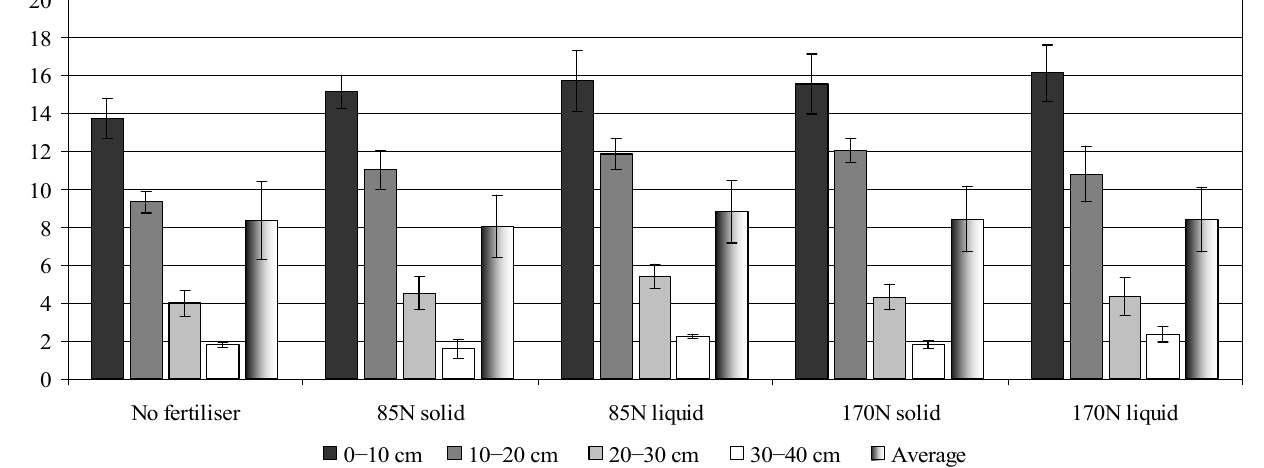
Figure 4. SOC content in grassland in Fluvisol, 2019.